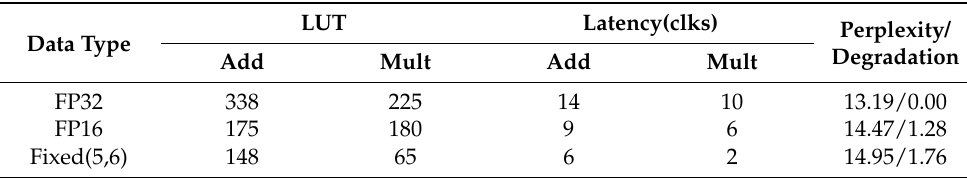
Table 2. Comparison among different